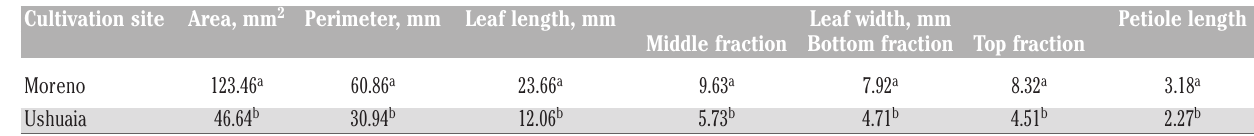
Table 1. Berberis microphylla morphological characteristics and measures according to the cultivation site. Cultivation site Area, mm 2 Perimeter, mm Leaf length, mm